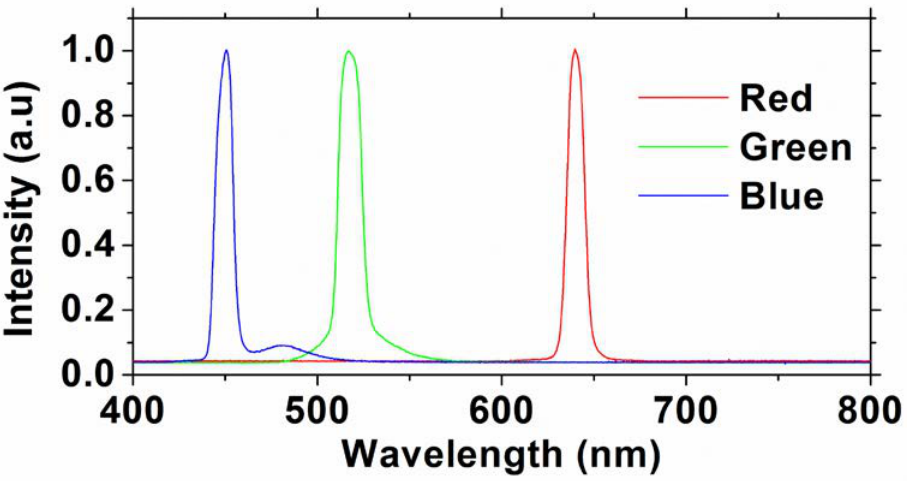
Figure 3. Experimental optical spectra of the RGB LDs.